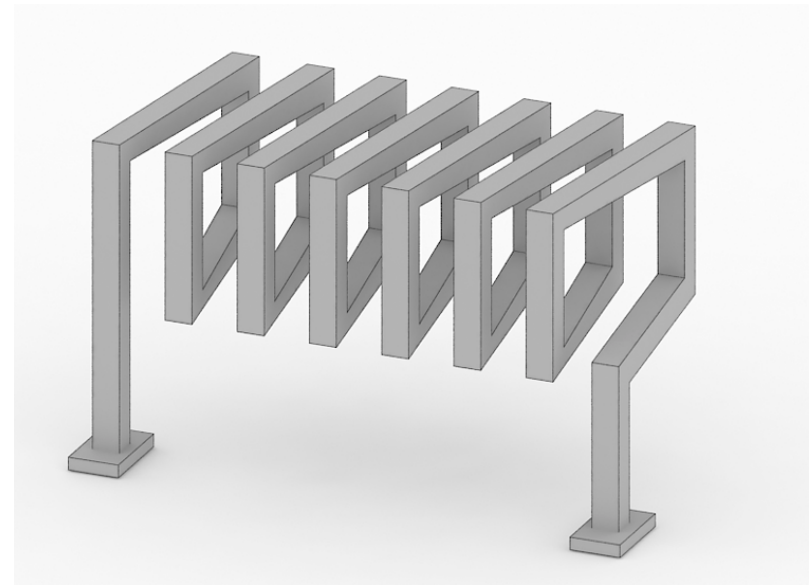
Figure 7. A schematic of an integrated solenoid-type inductor with an air gap.